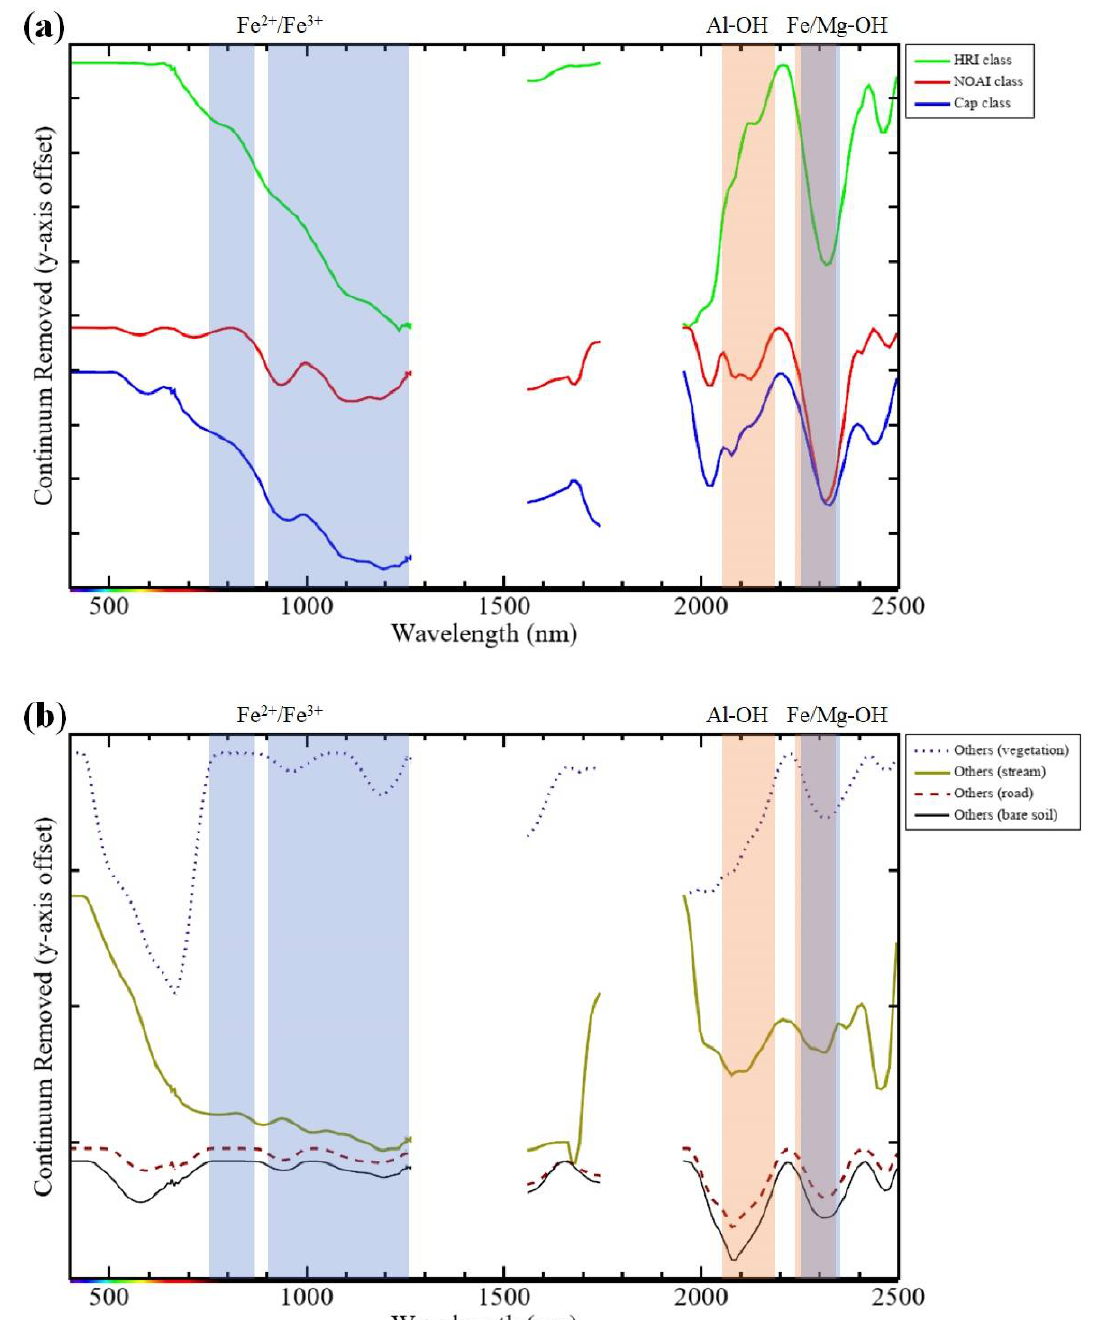
Figure 4. Averaged continuum removed reflectance distributions of image endmember spectra collected from 2018 AVIRIS data. ( a ) presents the extracted end-members of HRI, NOAI, and CAP classes. ( b ) showed Others class, including vegetation, bare soil, road, and stream. Blue and orange color blocks indicate the major absorption ranges of HRI and NOAI, respectively. These block ranges have been used as the weighted-multi ranges in MRSFF.